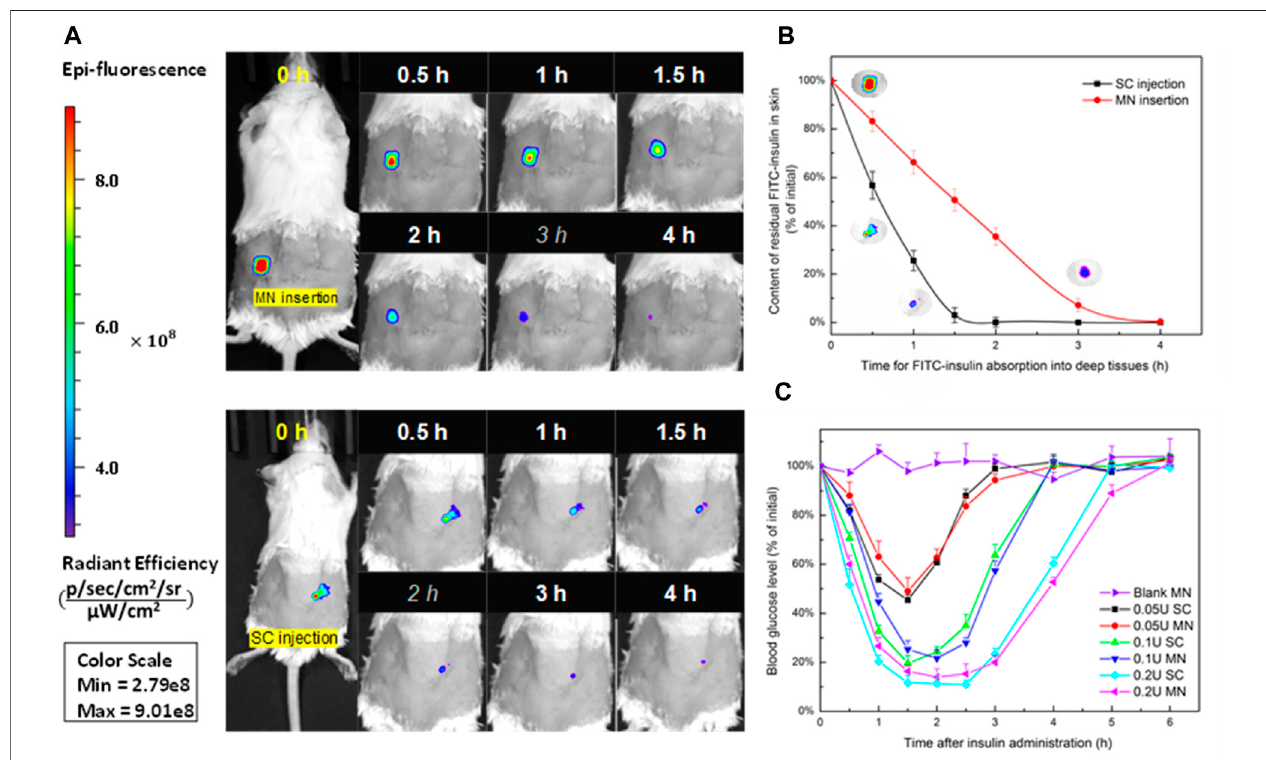
FIGURE7|(A) Absorptionpro fi leof0.1UofFITC-insulindeliveringintosubcutaneoustissueusingMNinsertionandSCinjectionrespectively. (B) ContentofFITC- insulin residual in the epidermis layer vs. absorption time after drug administration. (C) Blood glucose levels vs. time pro fi les of diabetic mice after administration of 0.05, 0.1, 0.2 U of FITC-insulin via MN insertion and SC